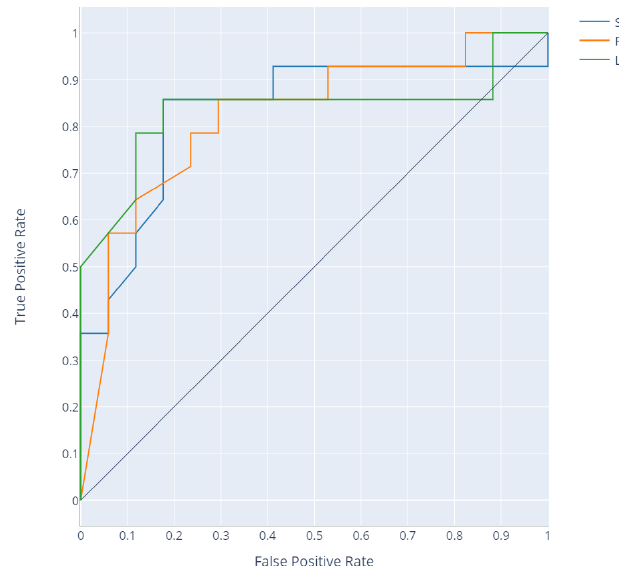
Figure 7. Receiver operating characteristic (ROC) curve for the division of the entire set of recordings into writhing movements and poor repertoire movements based on the percentage threshold of WM in predictions for each